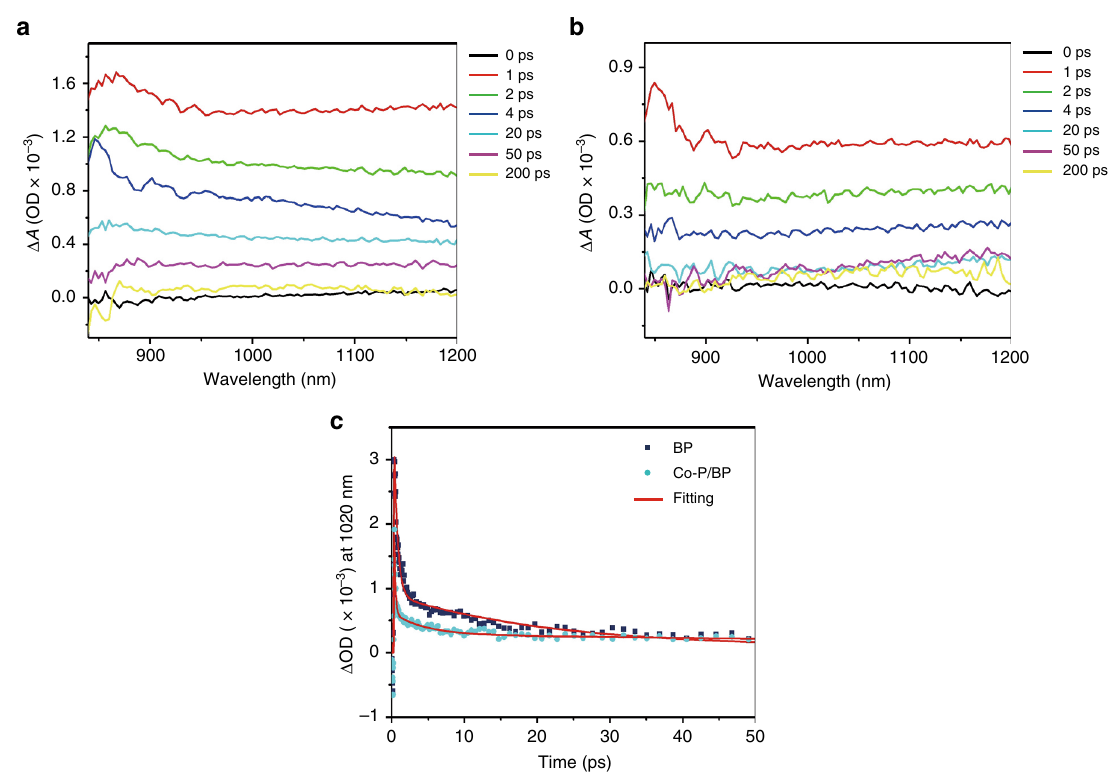
Fig. 6 Dynamics for the interfacial electron migration in the Co-P/BP nanosheets. a TAS spectra of the BP nanosheets. b TAS spectra of the Co-P/BP nanosheets. c Time pro fi les of the normalized transient absorption at 1020 nm. The data in Fig. 6c were fi tting by biexponential function. All the spectra are obtained by the excitation of a 500 nm pulsed